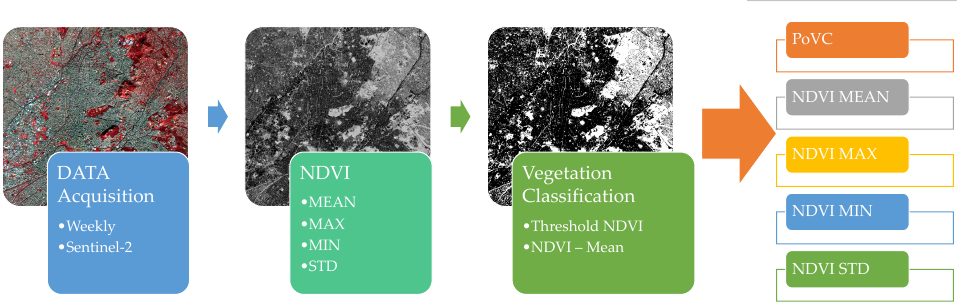
Figure 3. The environmental data acquisition step from remote sensing resources and the adopted process for the calculation of the urban